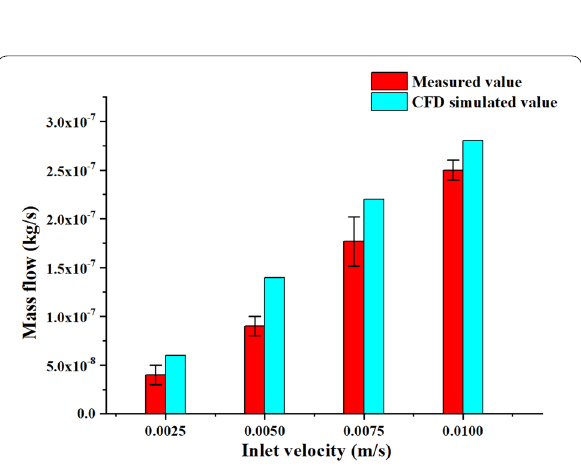
Figure 17 Mass flow in the side outlets obtained using CFD simulation and actual measurement (the pore diameter is 434